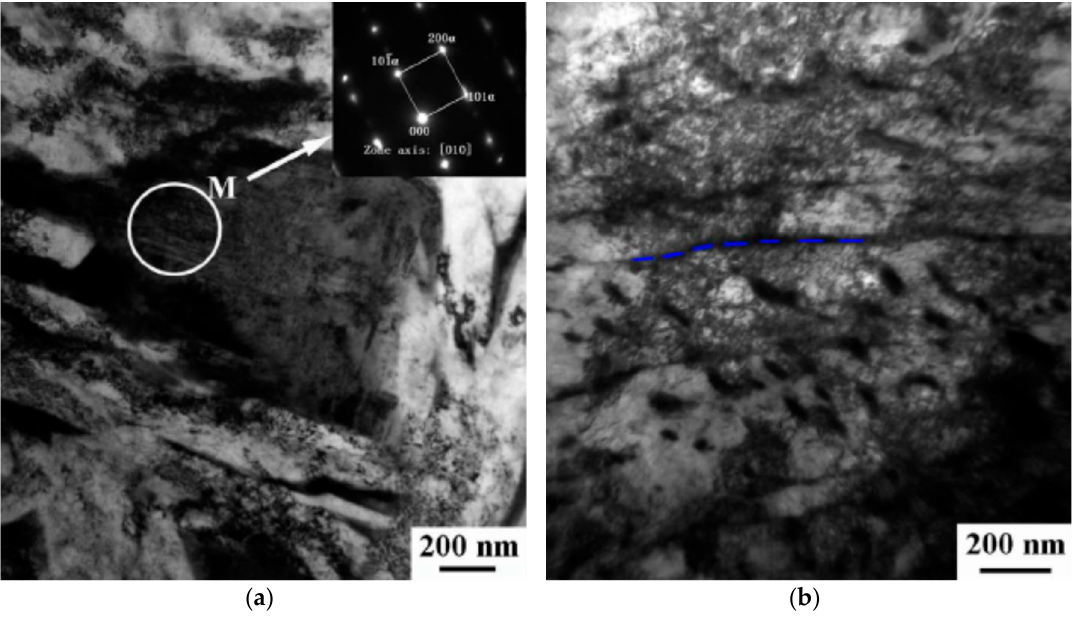
Figure 10. TEM images of low-cycle fatigue tests ( Δε /2 = 1.0%) for the [5]: ( a ) carbide-free lower-bainite; ( b ) carbide-bearing lower-bainite. Reprinted from Materials Science & Engineering A, Vol. 715, Xiaoyan Long, Fucheng Zhang, Zhinan Yang, Bo Lv, Study on microstructures and properties of carbide-free and carbide-bearing bainitic steels, Pages 10–16, Copyright (2018), with permission from Elsevier.